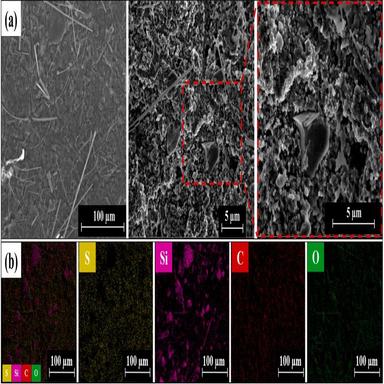
Post-cycling (a) SEM images and (b) elemental mapping. The analyses were conducted after 50 cycles at 0.05C.